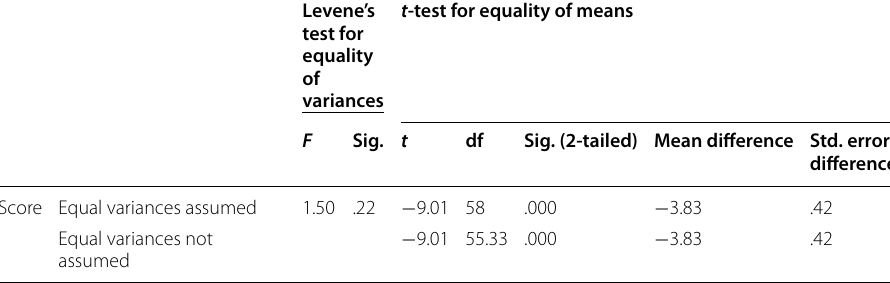
Levene’s t -test for equality of means test for equality of variances F